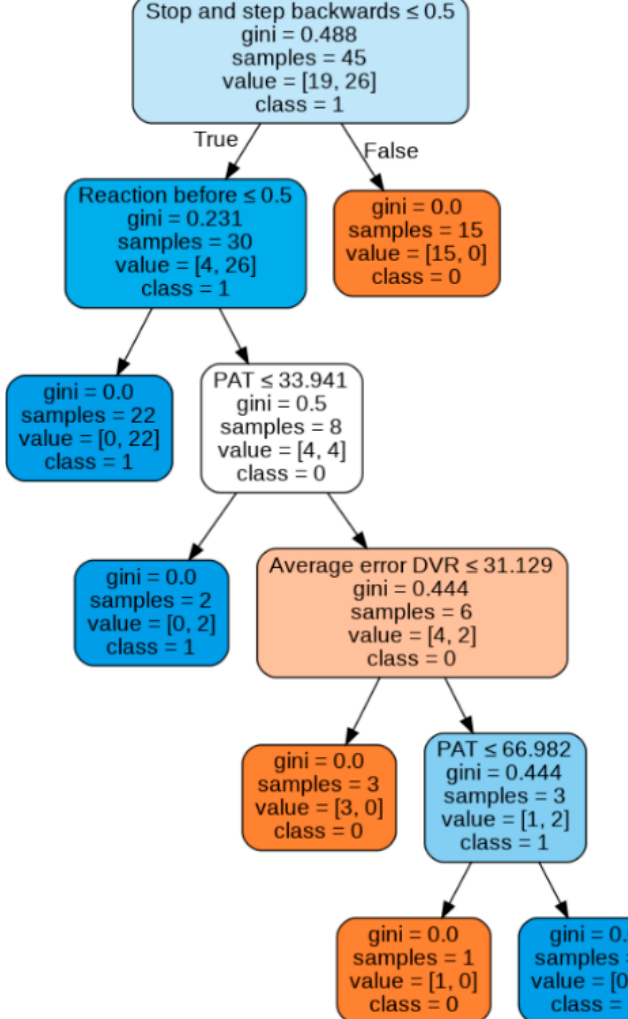
Figure 13. Individual decision tree model.